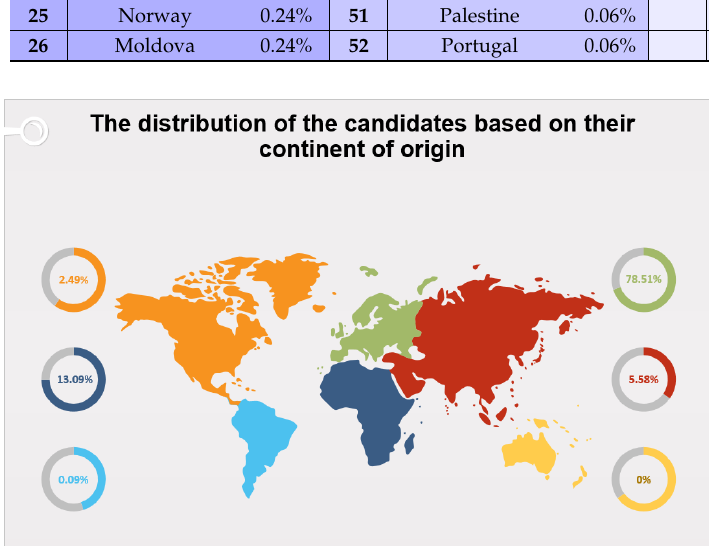
Figure 11. The distribution of the candidates based on their continent of